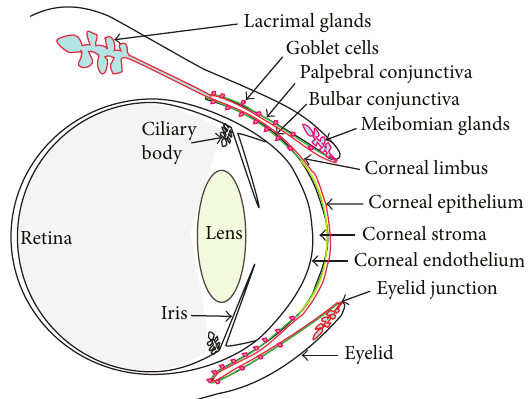
Figure 1: The ocular surface (shown as a thin red line) consists of the contiguous corneal (yellow) and conjunctival (green) surfaces bathed in the tear film and the associated ocular adnexa including the lacrimal and meibomian glands.